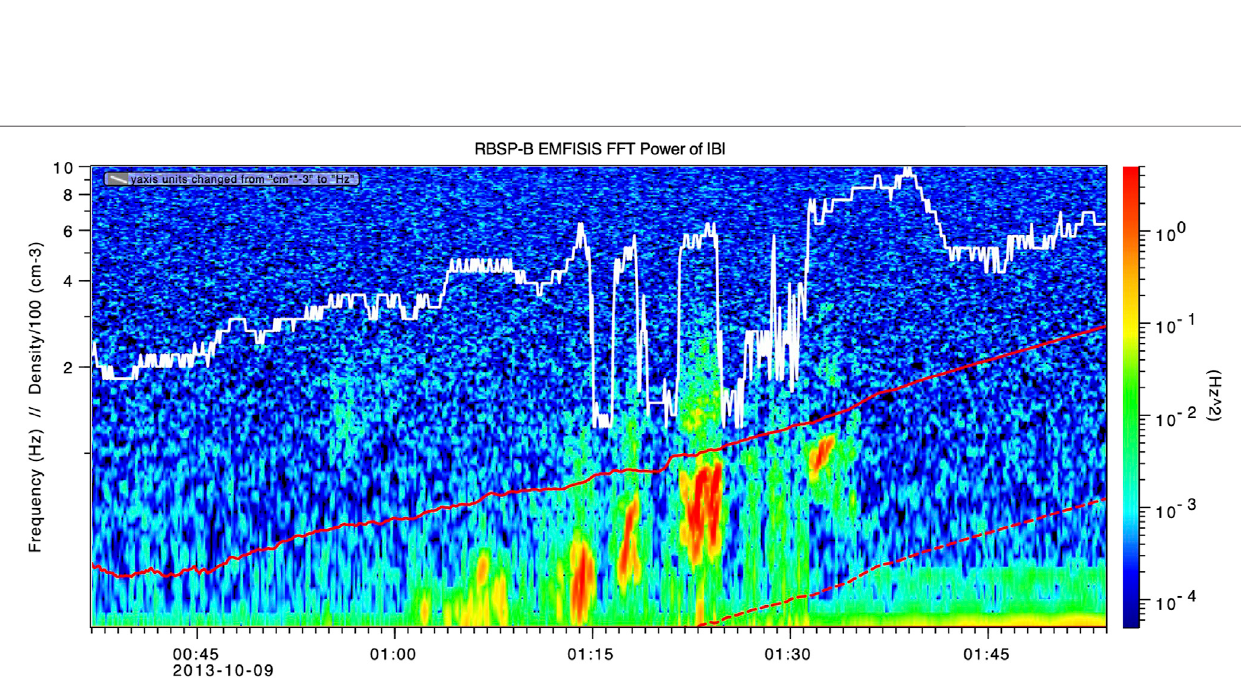
FIGURE 9 | He-band EMIC waves were observed immediately inside the plume outer boundary on each successive boundary crossing by RBSP-B (cf. Figure 7 ). Superimposed are the He+ and O+ ion cyclotron frequencies (red solid and dashed curves) and the EMFISIS plasma density (divided by 100; white) to delineate the plume